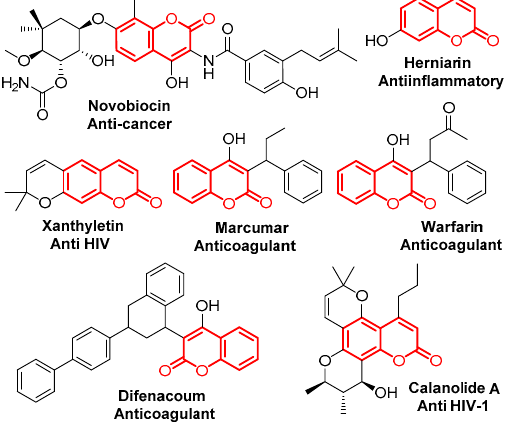
Figure 1. Selected examples of bioactive chromenones.